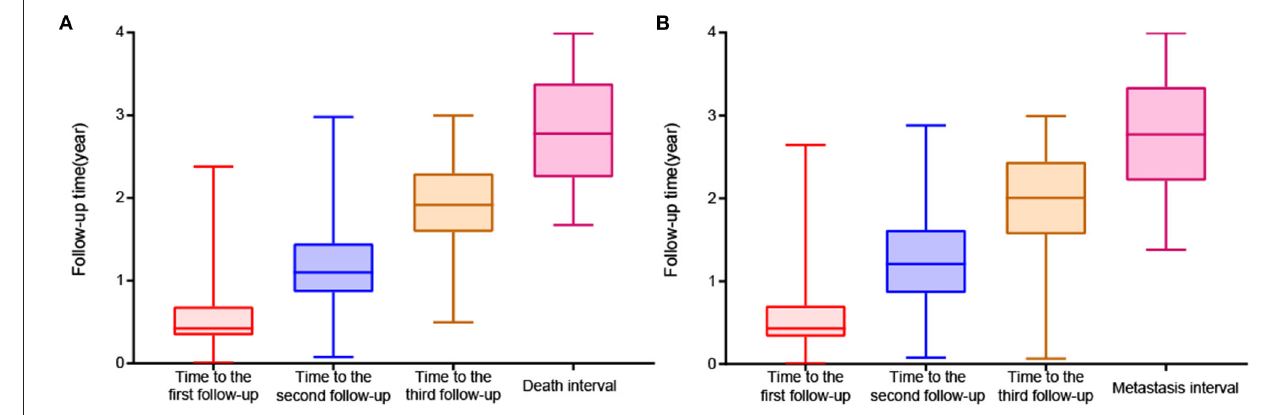
FIGURE 3 | Boxplot of follow-up time. (A) Death analysis. (B) Metastasis analysis.